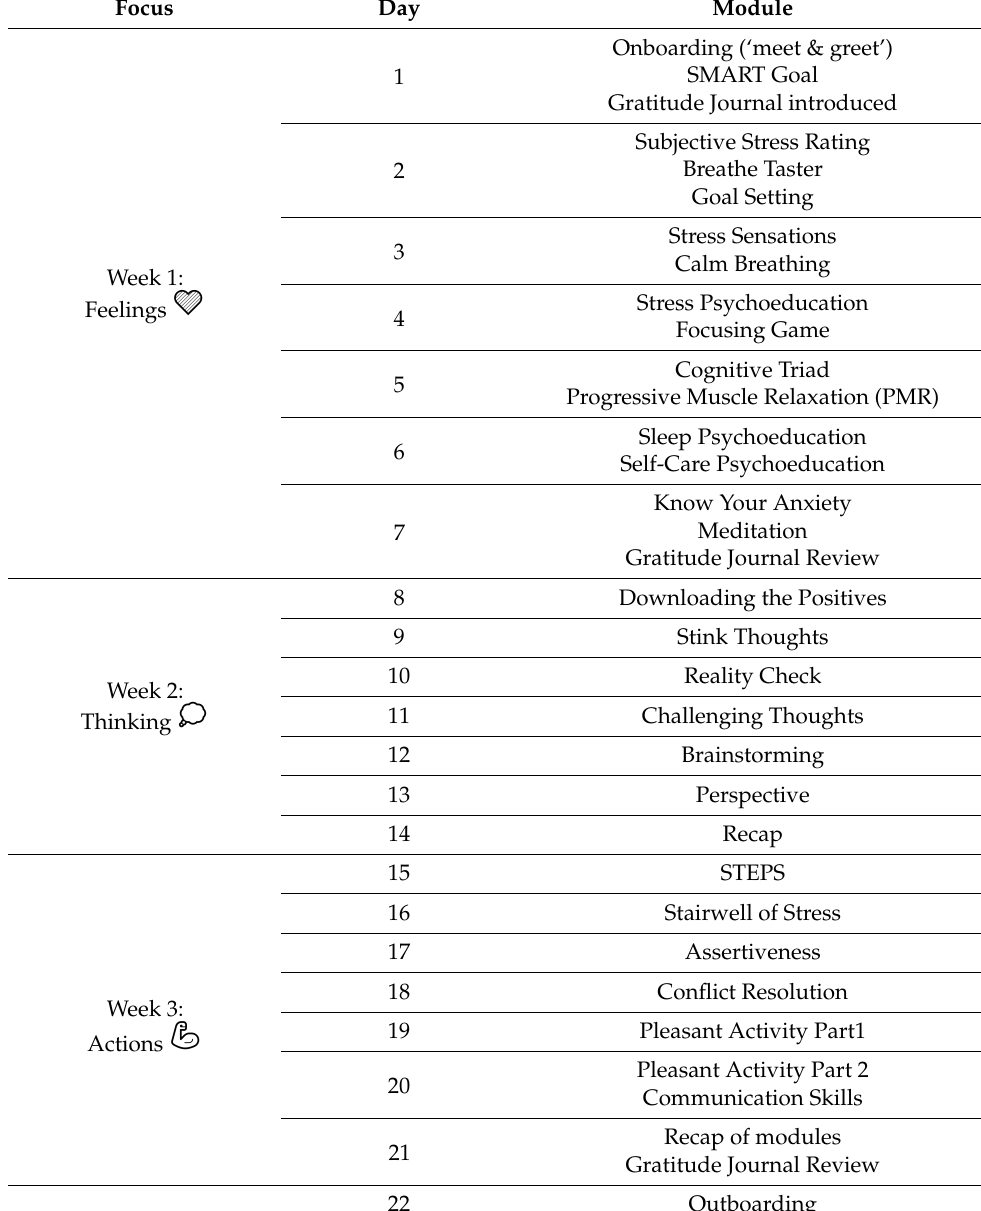
Table 1. Summary of content of the 21-Day Stress Detox Chatbot.